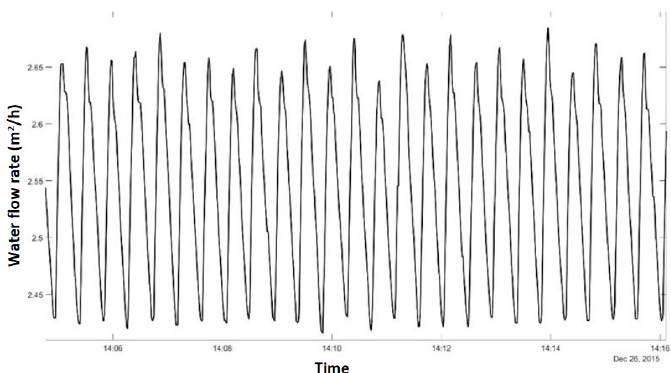
Figure 8. Noisy sensor signal consisting of a sinusoidal structure.